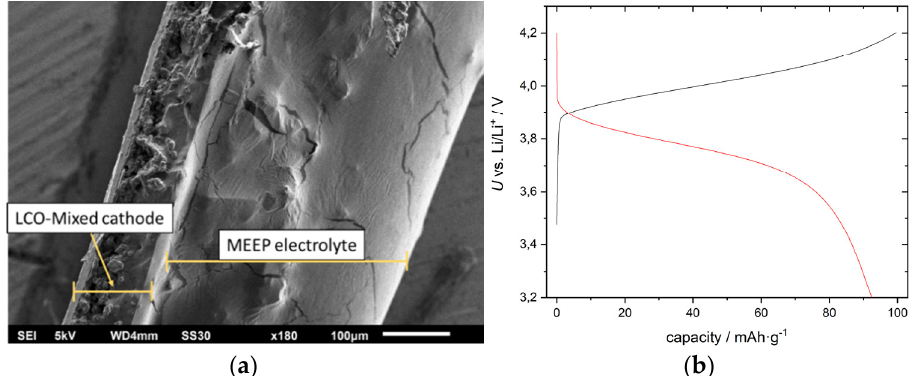
Figure 7. SEM image of a MEEP cell cross-cut ( a ) and a representative charge-discharge curve of this cell type ( b ).